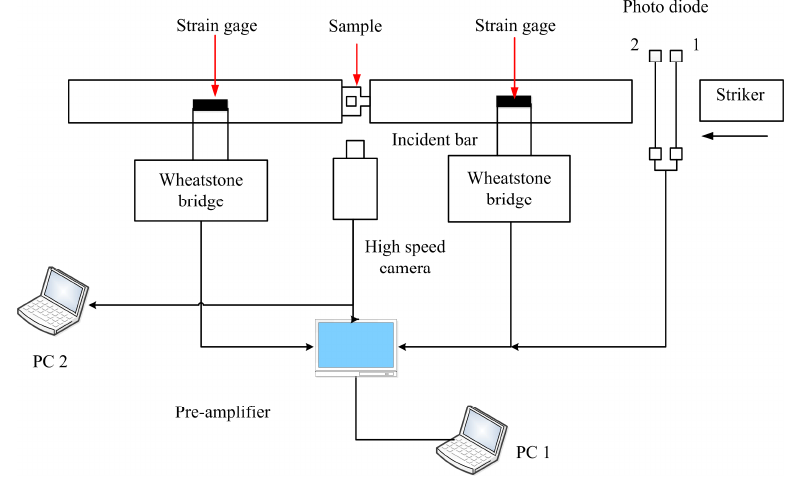
Figure 2. Schematic representations of the shear strain measurement device for a forced shear experiment.